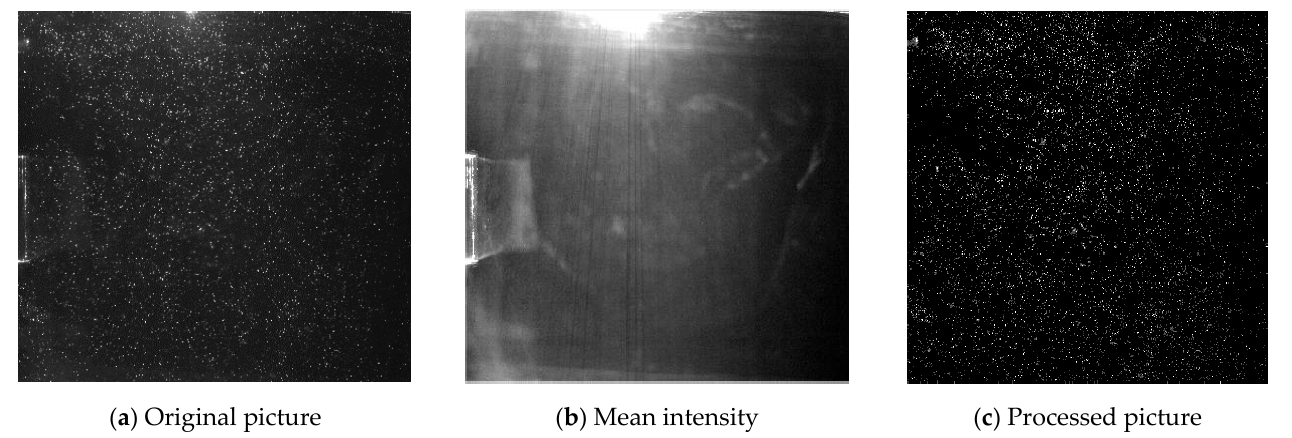
Figure 3. The effect of subtracting the mean intensity: ( a ) Original picture of the particles; ( b ) Subtracted mean intensity; ( c ) Picture of the particles without mean intensity.